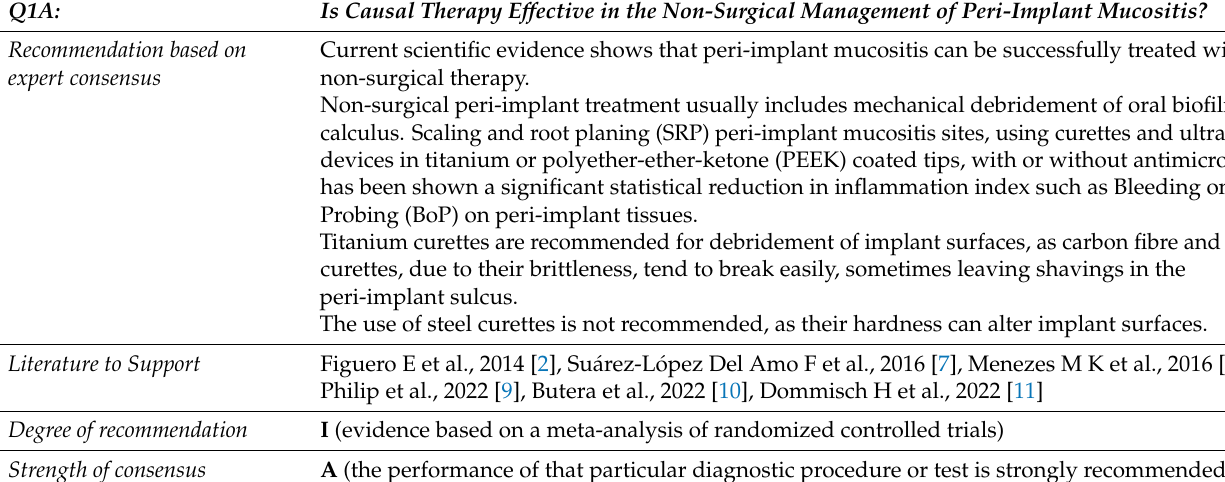
Table 2. Peri-Implant Mucositis